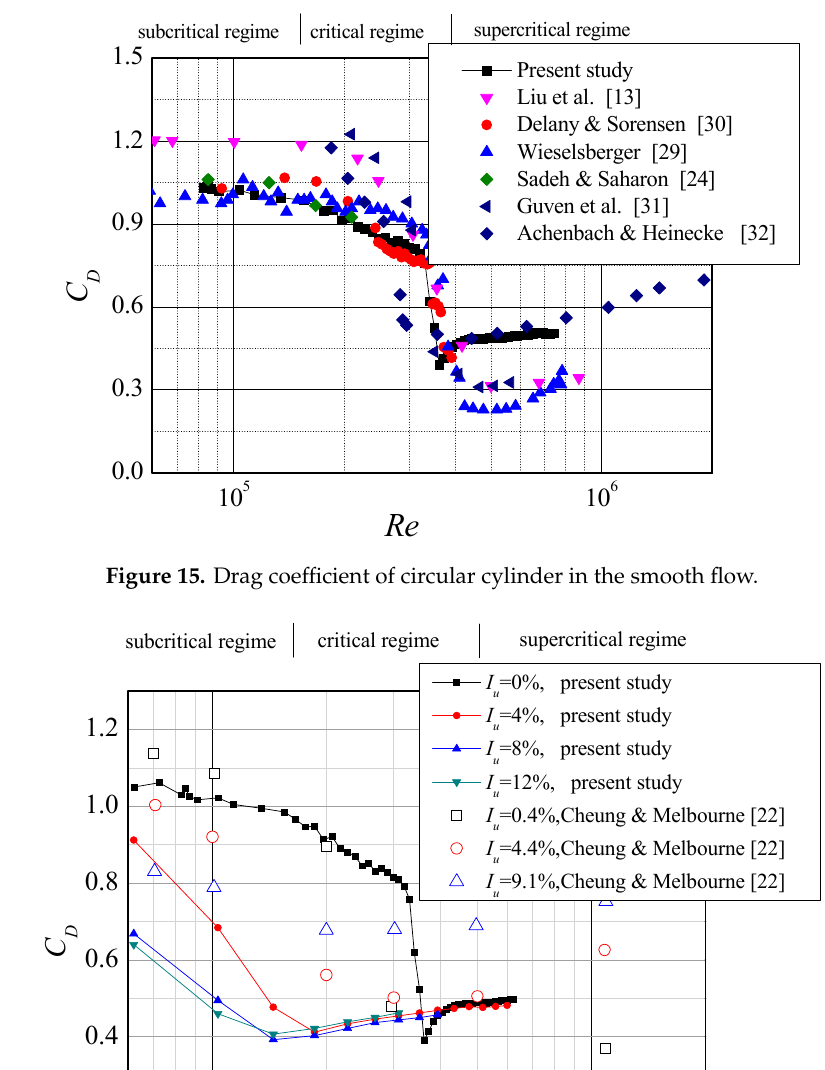
Figure 15 . Drag coefficient of circular cylinder in the smooth flow.